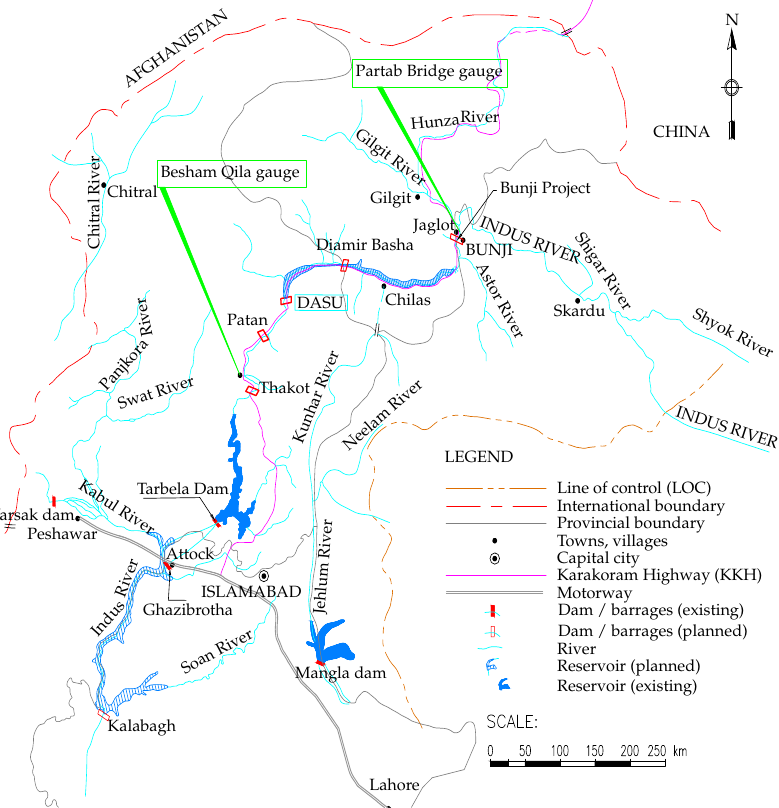
Figure 1. Locations of study gauges in the study area. Modified from